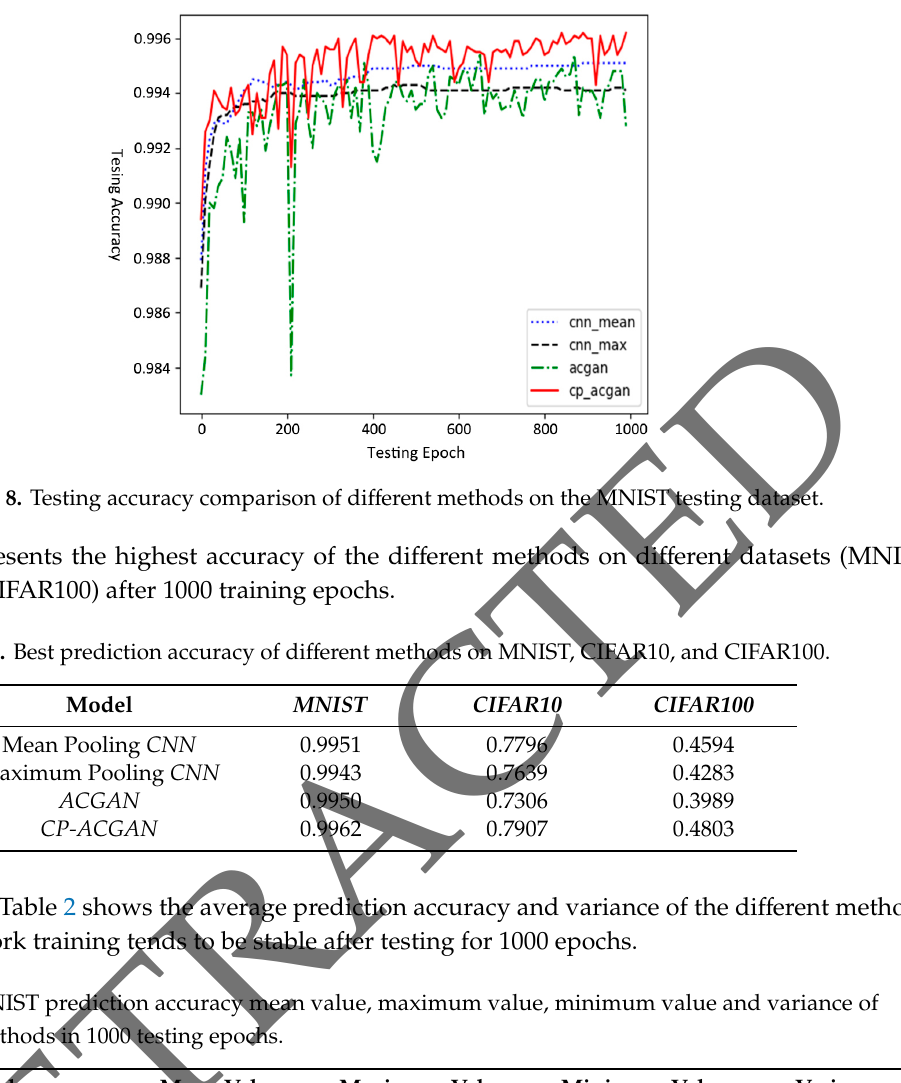
Figure 7. Classification effect of different methods on the MNIST training dataset.